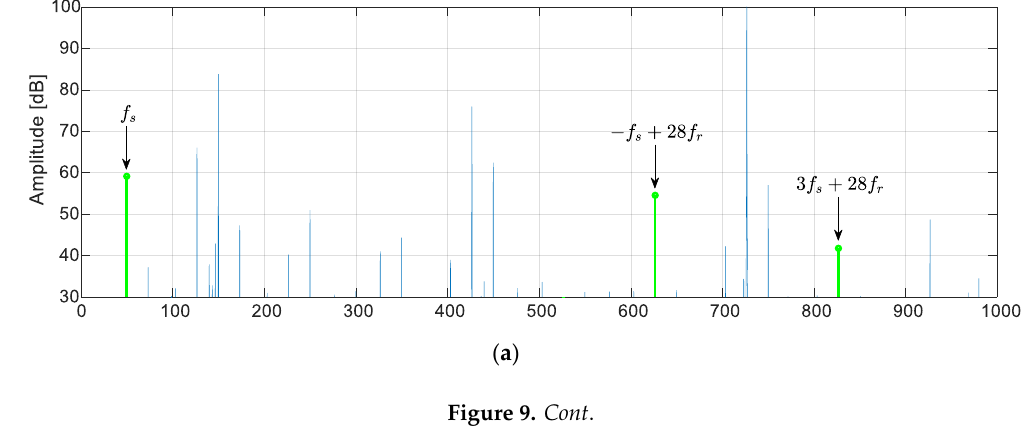
( b ) Figure 9. ZSC spectrum of motor with static eccentricity for the stator winding connections: ( a ) delta connection; ( b ) wye connection with neutral wire. ( a ) ( b )